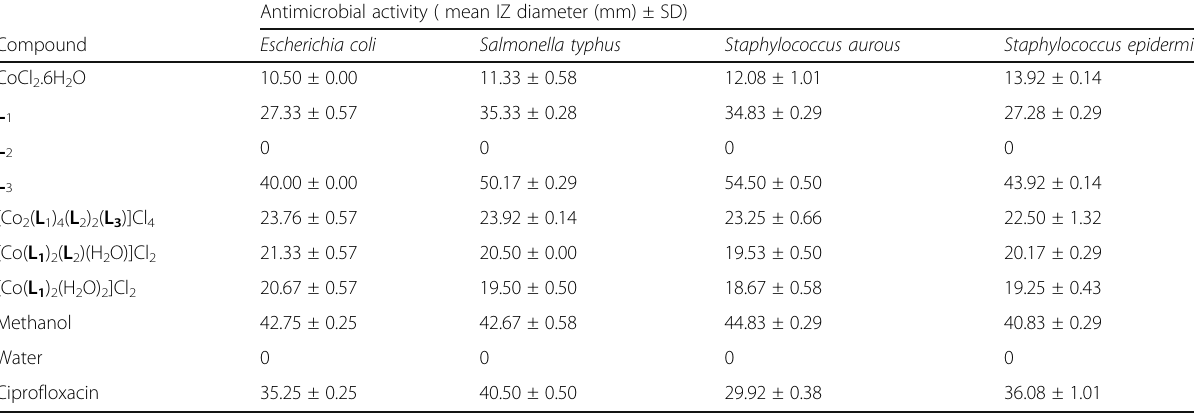
Table 4 Antibacterial activity of CoCl 2 .6H 2 O, ligands, metal complexes, and reference